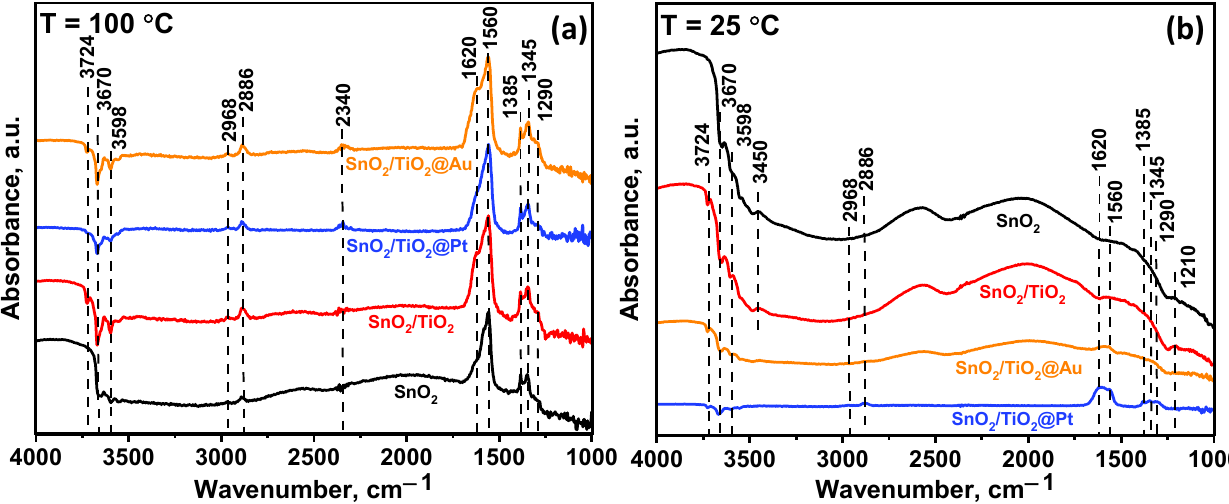
Figure 11. In situ DRIFT spectra of the samples after 40 min HCHO (20 ppm) exposure at T = 100 °C ( a ) and T = 25 °C ( b ).